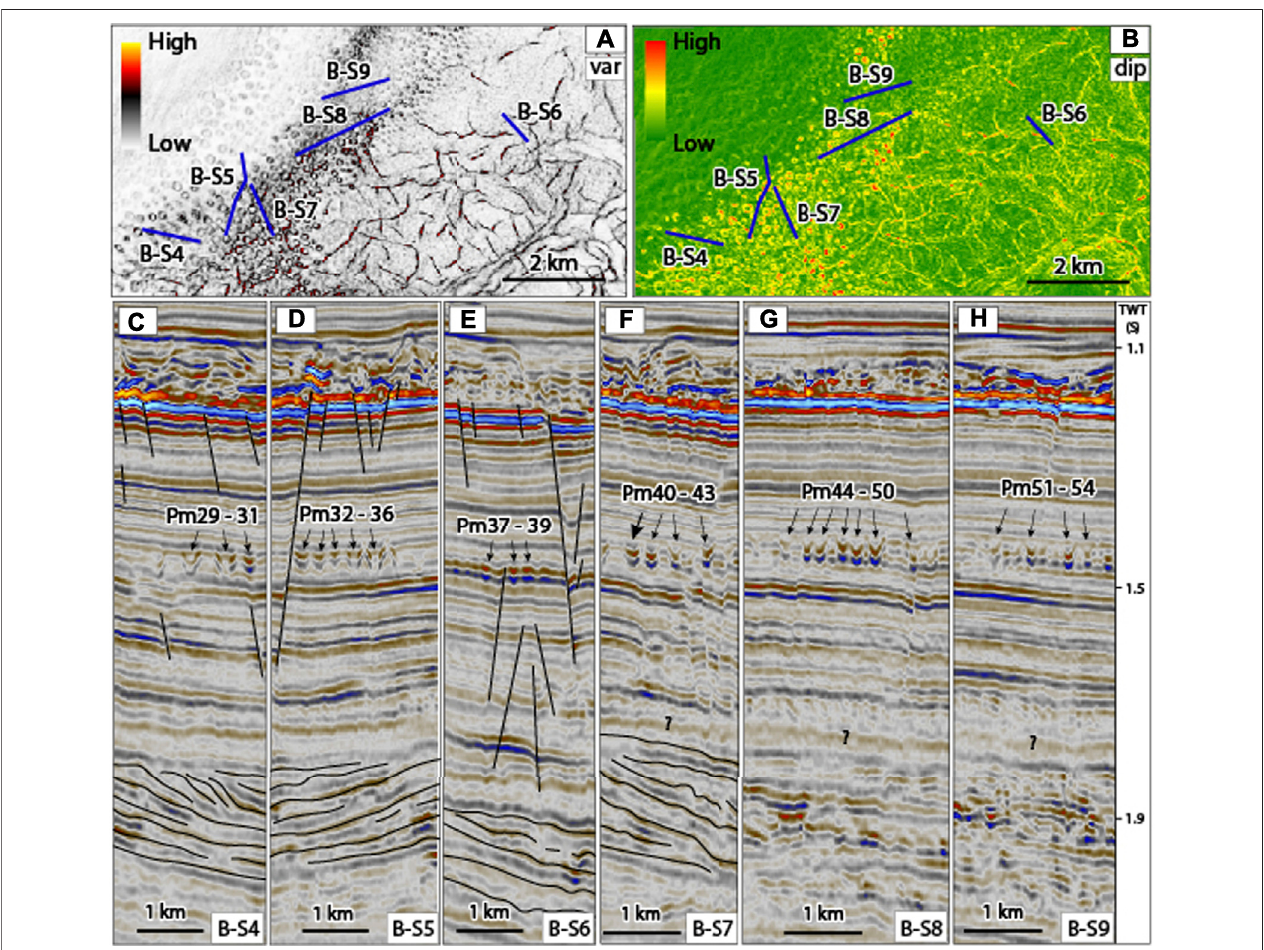
FIGURE 10 | (A) The variance map shows sub-round to round-shaped pockmarks on the top view with low to high discontinuity values (0.5 – 0.8), while (B) the consistent dip map shows slope angles of paleo-pockmark walls between 4 and 15 ° (low to high value). (C – H) Seismic sections B-S4 to B-S9 show the shape of 26 paleo-pockmarks (Pm29 — Pm54) in pro fi le view, as V- and U-shaped pockmarks with a size range from 131 to 350 m width and 16 – 45 ms (TWT) depth. The progradation seismic pattern of clastic sediments is observed beneath the paleo-pockmark interval.